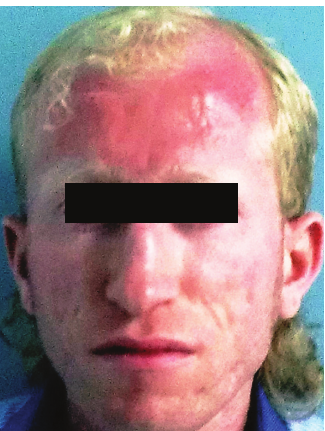
Figure1:Patientexhibitingoculocutaneousalbinismandexotropia.